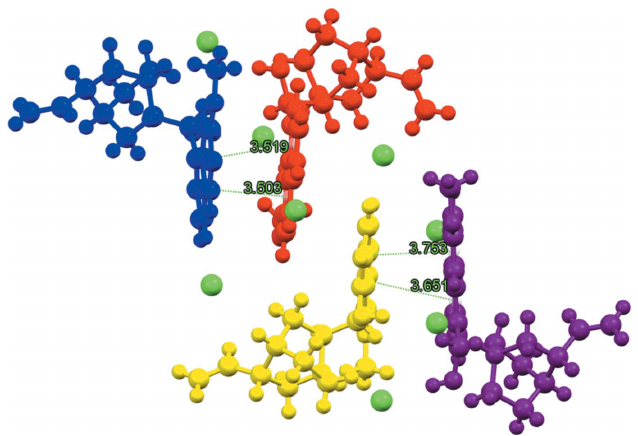
Figure 4 (cid:2) – (cid:2) interactions between cationic moieties in the asymmetric unit. Centroid-centroid distances are shown in green.